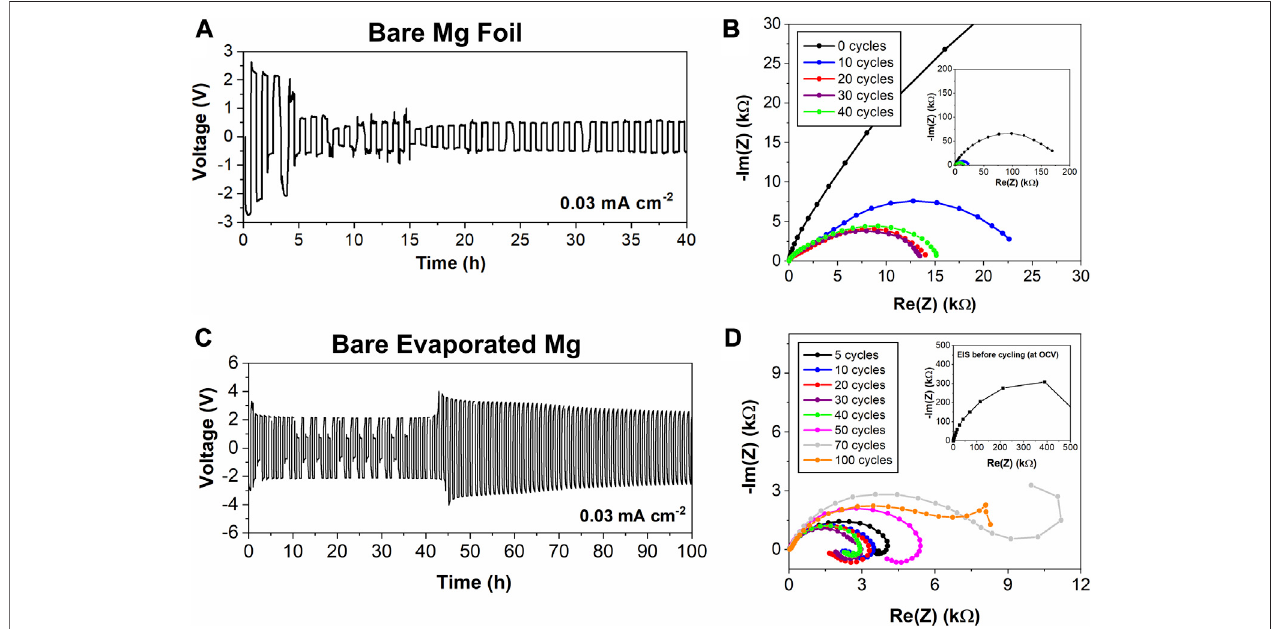
FIGURE 2 | Electrochemical analysis of bare Mg anodes for Mg foil in (A) and (B) , evaporated Mg in (C) and (D) (A) and (C) show galvanostatic cycling curves for symmetric Mg cells with 30 min constant current applied and (B) and (D) depict EIS analysis at the overpotential values reached in the galvanostatic cycling (EIS at the OCV in the inset).